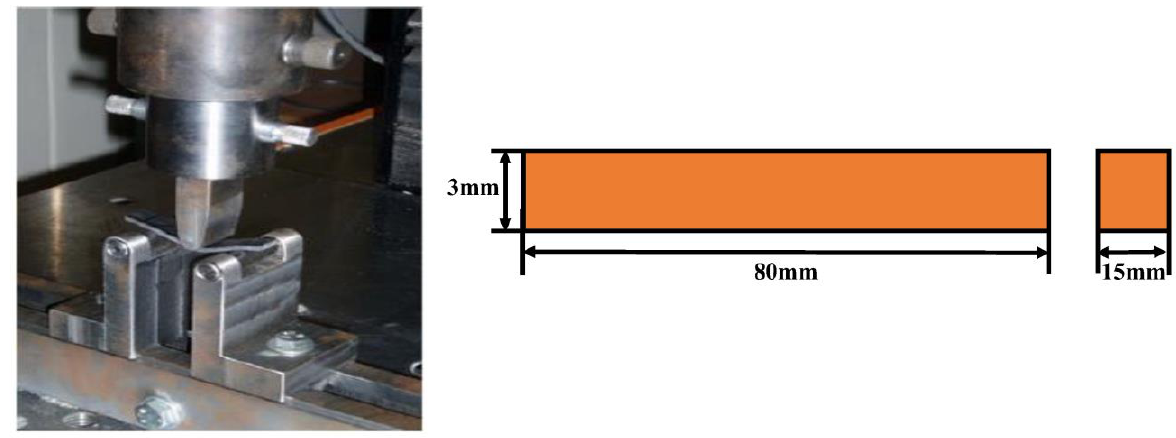
Figure 5. ILSS test arrangement.